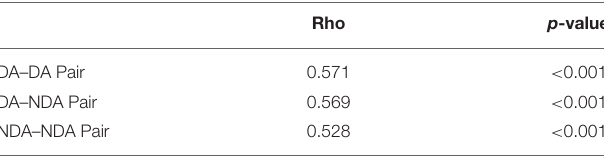
( Figure 6C ; 85% accuracy vs. chance levels of correct decoding [33% accuracy], permutation test, p < 0.001). In contrast, population averaged activity was decoded at chance levels ( Figure 6C ; permutation test, p = 0.240). Binned action number was discriminated from ensemble activity significantly more accurately than population-averaged activity [ Figure 6C ; = 21.435, p < 0.001]. Discrimination was stable across χ 2 (1) = 1.097, p = 0.578], and between low, medium, sessions [ χ 2 (2) = 3.614, p = 0.164]. There was and high action number bins [ χ 2 (2) no difference in accuracy between dopamine and non-dopamine = 1.133, p = 0.287]. When reward neurons [ χ 2 (1)